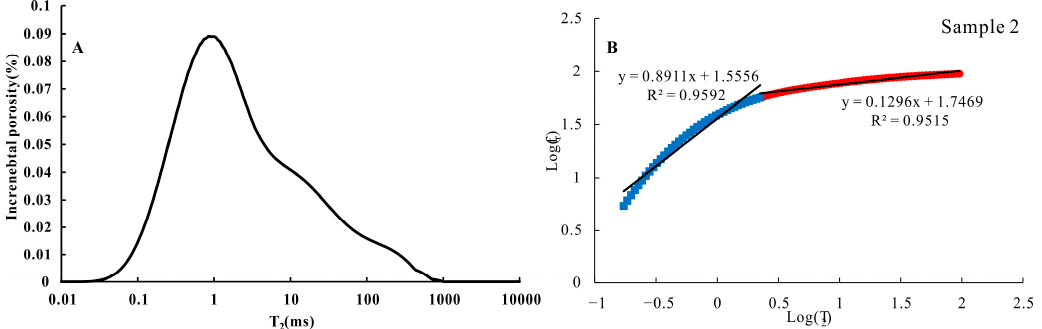
Figure 13. Trends of fractal dimension for fluid variation in different centrifugal speeds.